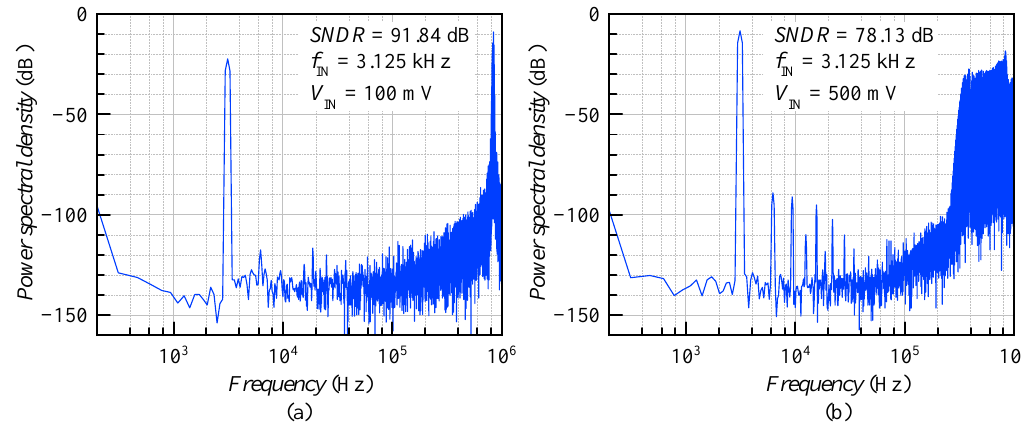
Figure 11. PSDof the ADSM for the sinusoidal input signal with an amplitude of ( a ) V IN = 100 mV and ( b ) V IN = 500 mV.